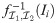
Collapse of the response behavior.(A) The mean (dark lines) and standard deviation (similar semitransparent light colors) of velocities of active control worms, binned for presentation purposes into five different groups of 40 worms each, based on the stimulus current. (B) The mean and standard deviation of velocities (same color code) in the same time period rescaled by fI1,I2-1(Ii). Rescaled mean velocities nearly collapse (see Fig 5 for quantification of the collapse). Note that the parameters I1 and I2 are optimized as in Materials and methods to collapse individual profiles, and not the five mean profiles illustrated here.